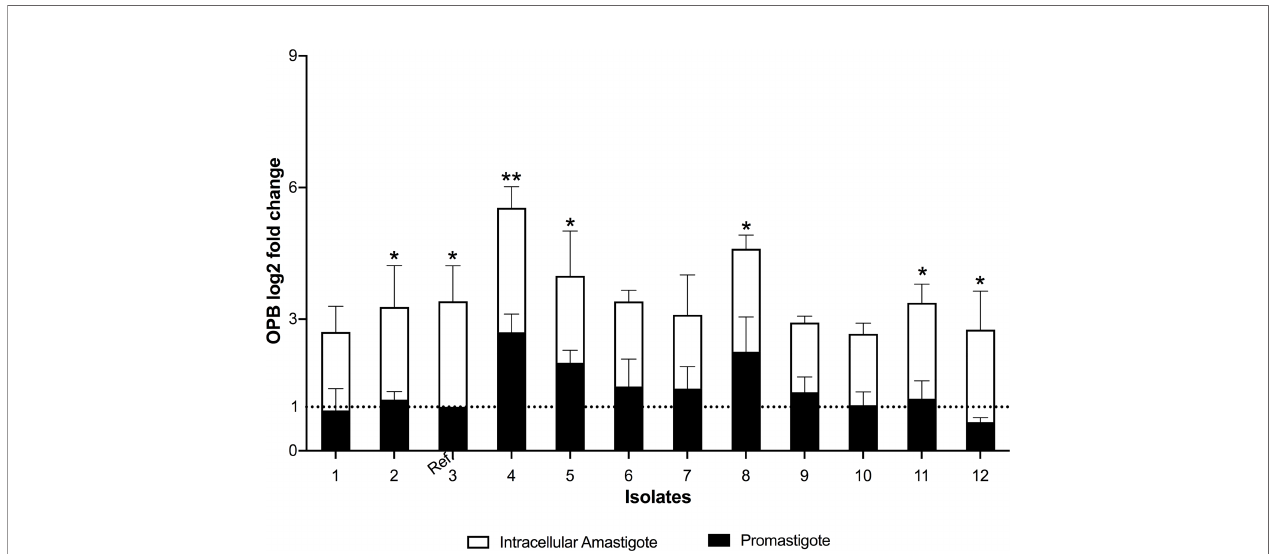
FIGURE 5 | Oligopeptidase B differential gene expression. The real-time quantitative PCR results show the relative quanti fi cation values of oligopeptidase B (OPB log2 fold change). Actin and protein S8 were used as endogenous controls. The DD Ct value of OPB gene was calculated pair-to-pair between promastigotes and intracellular amastigotes, and the promastigote sample with lowest expression was set as the reference sample (promastigote form of isolate 3, Ref.). The dashed line indicates the reference sample relative quanti fi cation level = 1. The graph presents the mean of two independent experiments performed in triplicate. Statistical difference is represented by * p ≤ 0.05 and ** p ≤